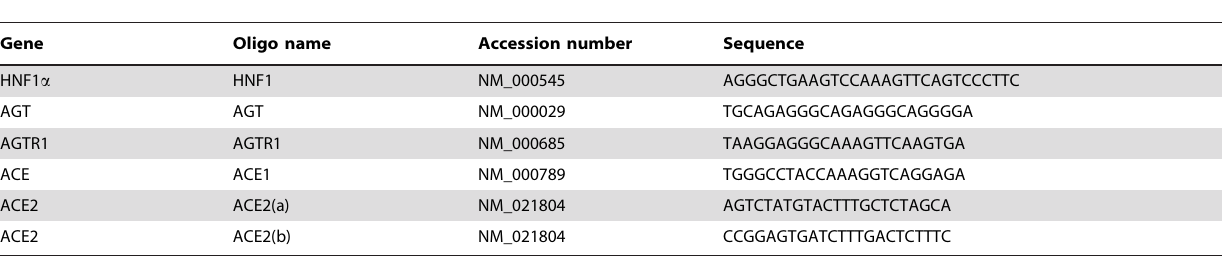
Table 1. Shift-probe